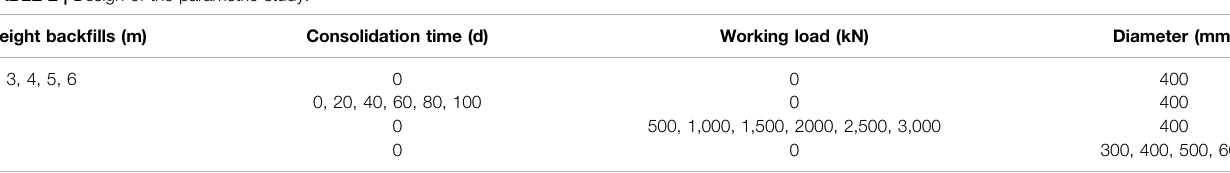
Table 2 listed the in fl uence factors on NSF of the PHC pile. For